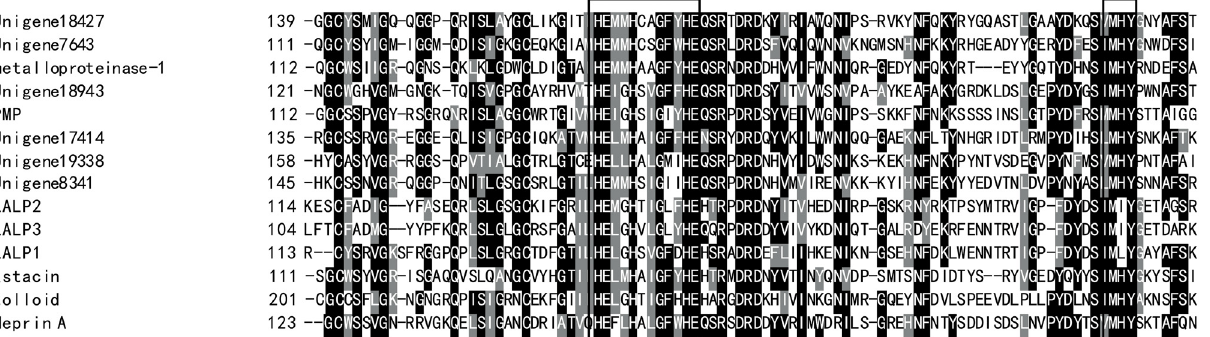
Fig 3. Multiple sequence alignment of astacin-family enzymes. The deduced amino acid sequences of unigenes 18427, 7643, 18943, 17414, 19338 and 8341 were aligned with Loxosceles intermedia LALP 1, 2 and 3 (A0FKN6, C9D7R2 and C9D7R3, respectively), metalloproteinase 1 from H . vulgaris (AAA92361), astacin from A . astacus (CAA64981), PMP1 from Podocoryna carnea (CAA06314), tolloid from Drosophila melanogaster (AAF56329) and Meprin A from Homo sapiens (AAI36560). Sequence accession numbers are shown in brackets. The characteristic astacin family signatures are boxed. Black and grey indicate amino acids that are identical or highly conserved, respectively, across all aligned sequences. Absent amino acids are indicated by dashes (-) to improve the alignment.